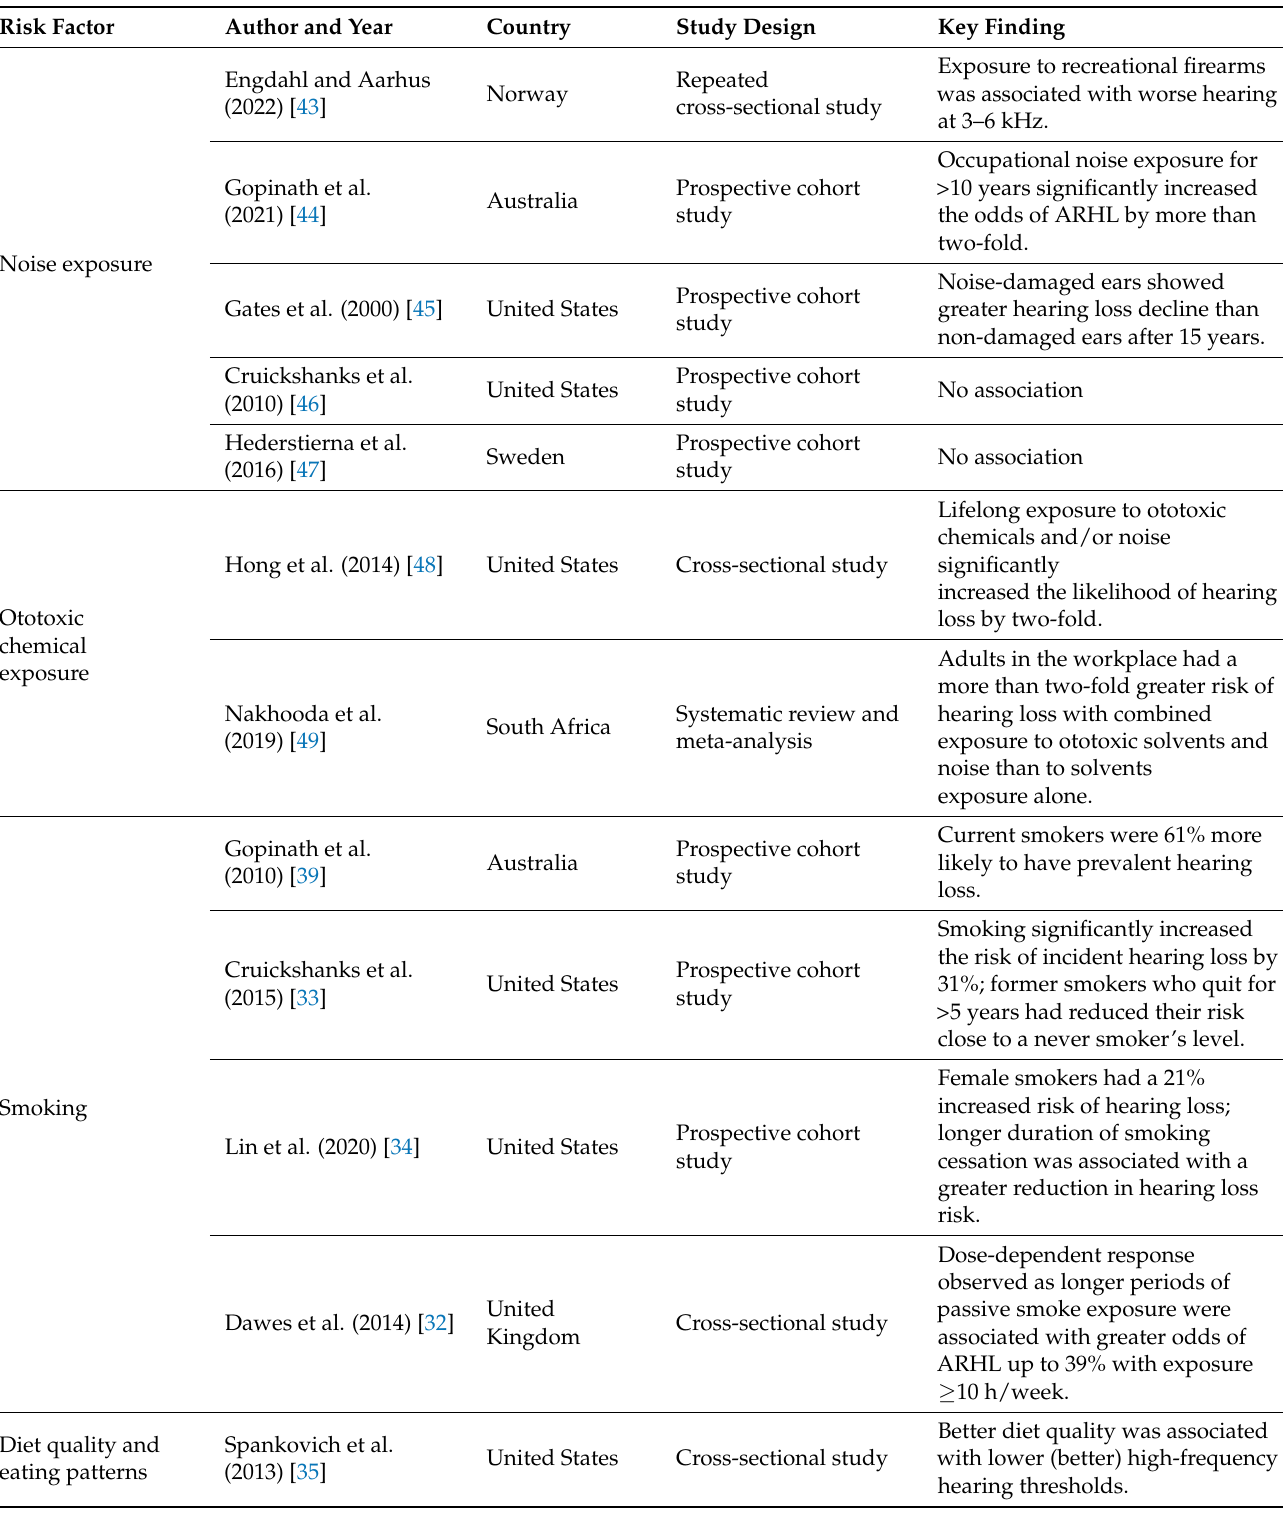
Table 1. Overview of the risk factors and evidence of the association with